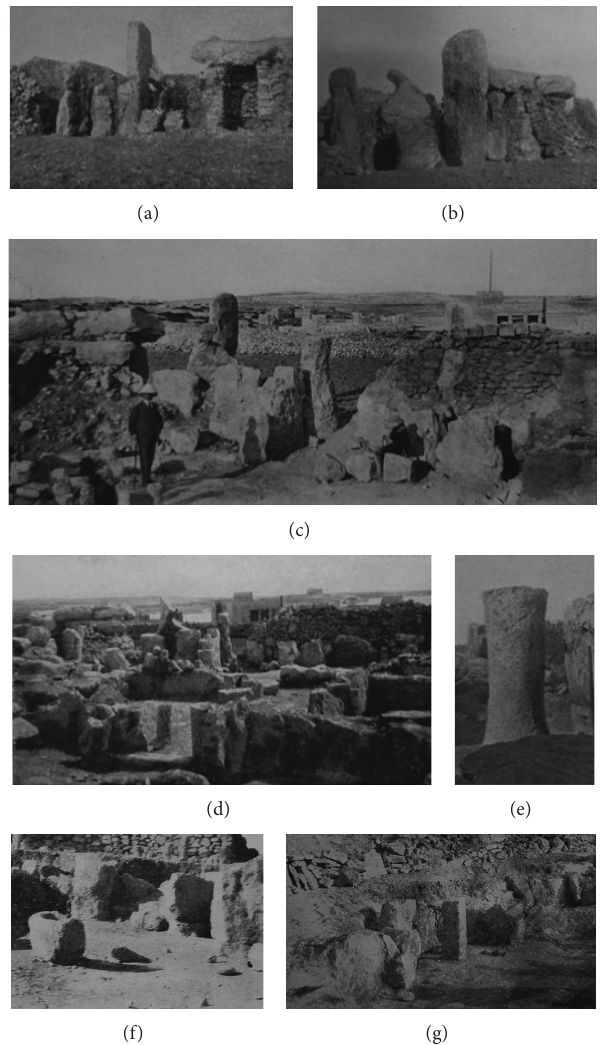
Figure 1: The temple at the time of Murray’s excavations: (a) general view from the north-east (1923); (b) great Upright from the south- east (1923); (c) great entrance, showing megalith built into wall (1925); (d) north-west Apse (1925); (e) large biconical pillar (1923); (f) mortar in situ (1925); (g) niche showing the three standing stones (1923).